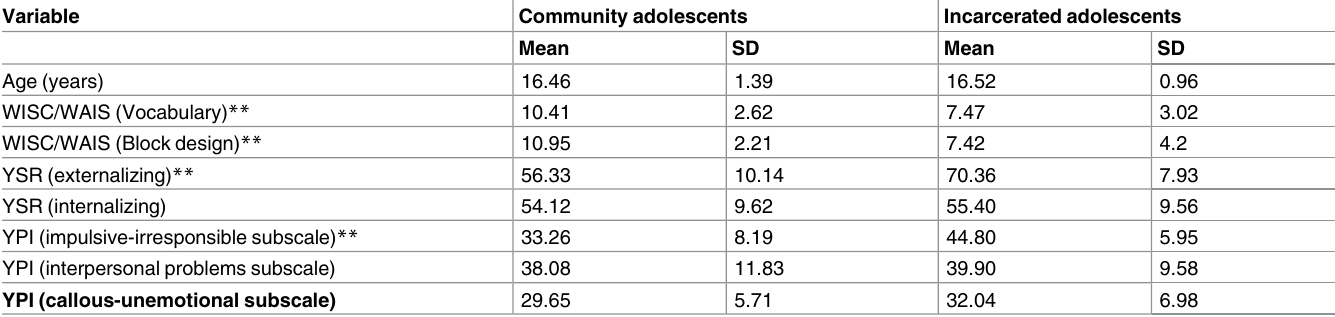
Table 2. Sample characteristics results.